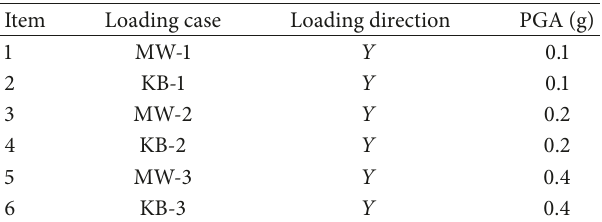
Table 3: Loading cases, where PGA indicates the peak ground acceleration (unit: